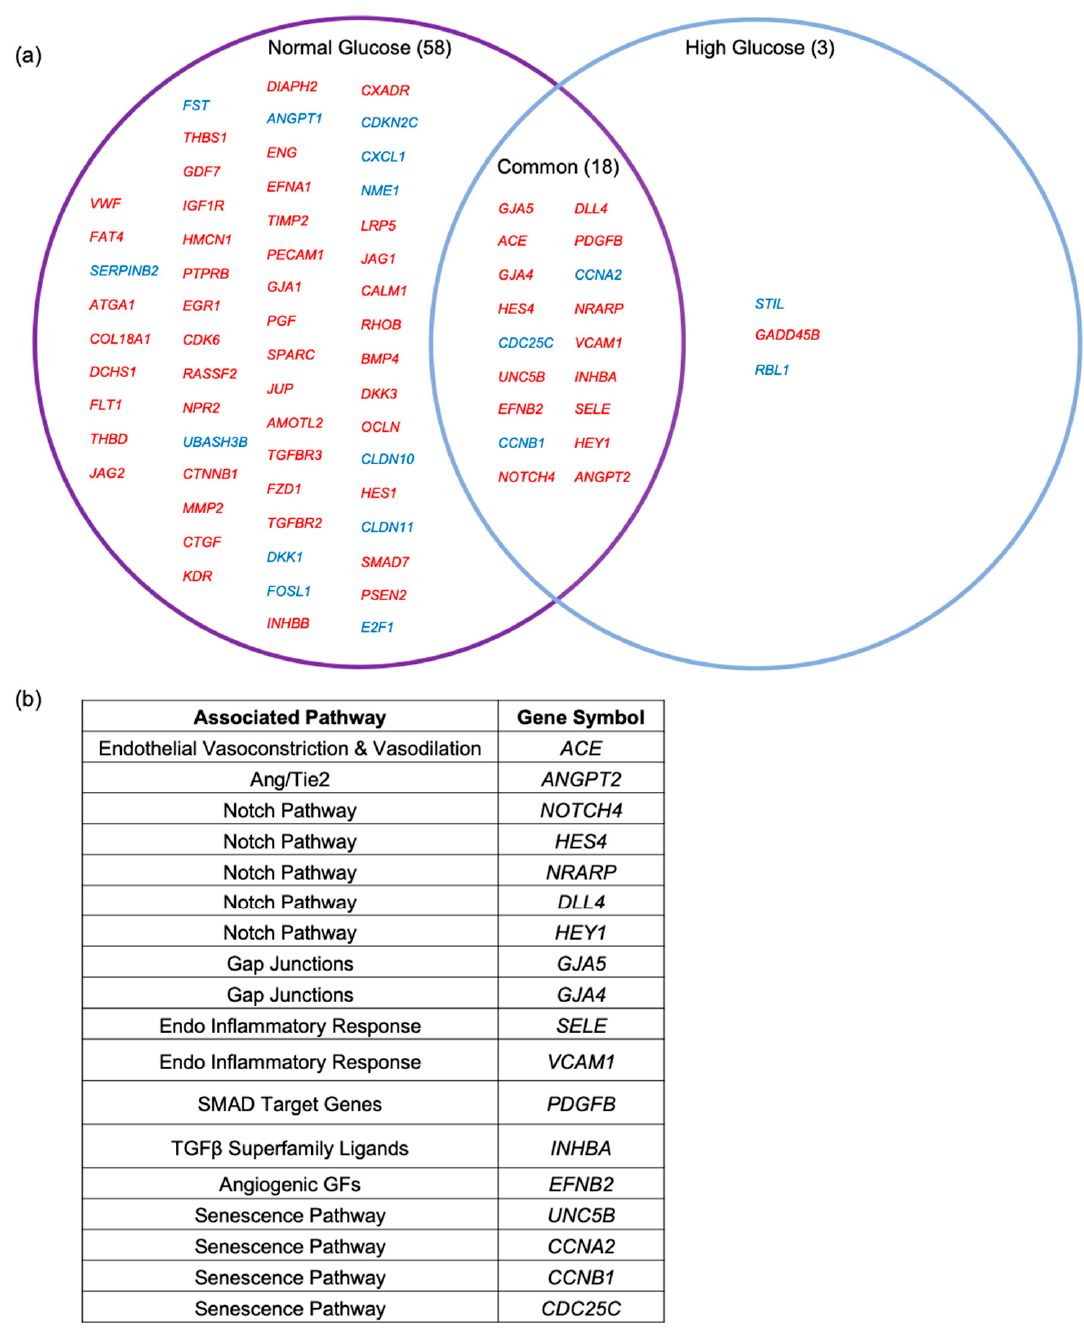
Figure 2. Eighteen of the common anti-VEGF DEGs were known to govern vascular homeostasis. ( a ) Venn diagram depicting the list of VEGF/anti-VEGF regulated genes that are known vascular homeostasis (VH) genes in normal- and high-glucose HRECs. Genes listed in red were upregulated in VEGF-treated cells; genes listed in blue were downregulated in VEGF-treated cells. ( b ) Chart showing the pathways associated with the 18 VH genes that are regulated by VEGF/anti-VEGF in both glucose concentrations.